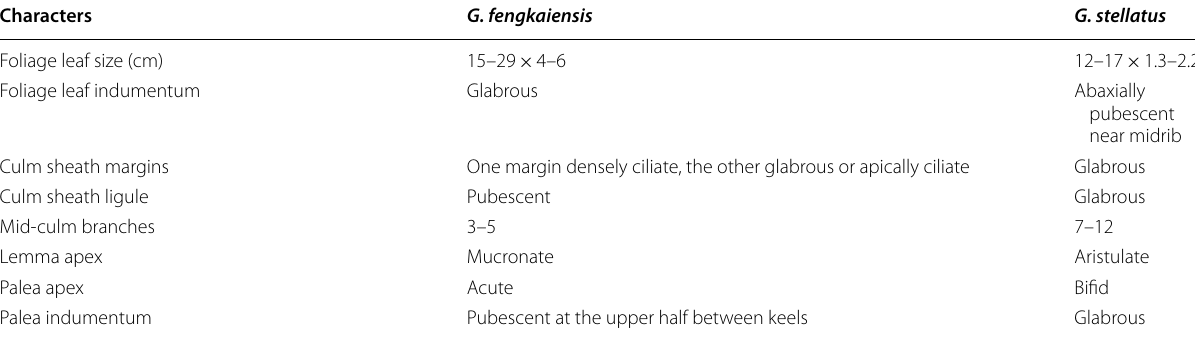
Table 1 Morphological comparisons of Gelidocalamus fengkaiensis and G.